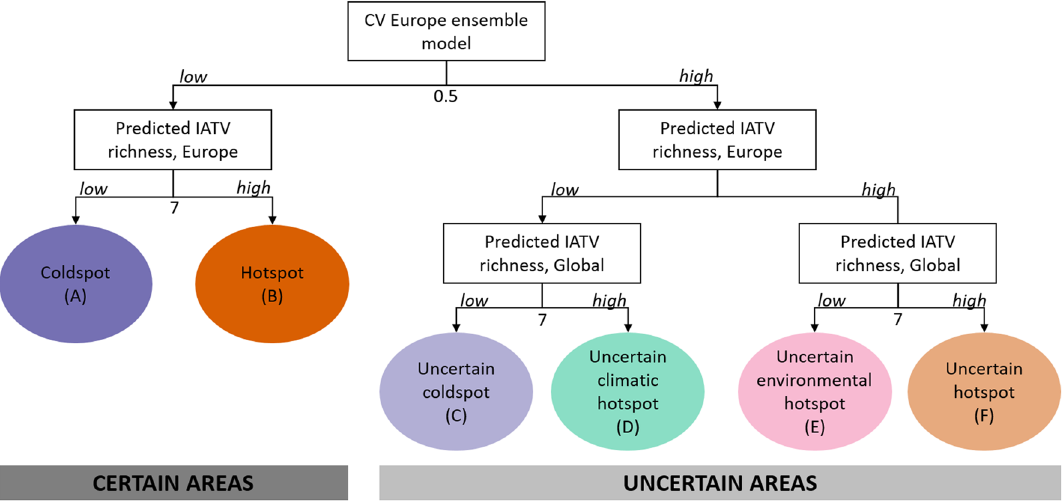
Figure 1. Classification tree applied to determine the category of each grid-cell within the ‘priority management areas’ classification. CV Europe ensemble model is the average of the coefficient of variation of the 15 IATV European ensemble models (including all type of predictors). Predicted IATV richness, Europe is the sum of all binary predictions of the 15 IATV European ensemble models. Predicted IATV richness, Global is the sum of all binary predictions of the 15 IATV global ensemble models (including only climatic predictors). Thresholds to determine high and low values are the central values for each variable (CV = 0.5; predicted IATV richness = (D, Fig. 2). No grid-cell was identified as an ‘uncertain environmental hotspot’ (E), characterized by high IATV richness according to the European model (all environmental predictors) and low IATV richness as for the global model (only climatic predictors; Fig. 1). Uncertainties associated with dissimilar environmental conditions (measured by MESS) and with GBIF spatial bias (measured by half-ignorance index) were on average higher within ‘uncertain coldspots’ and ‘uncertain climatic hotspots’, being minimum within ‘hotspots’ (Table 4). These